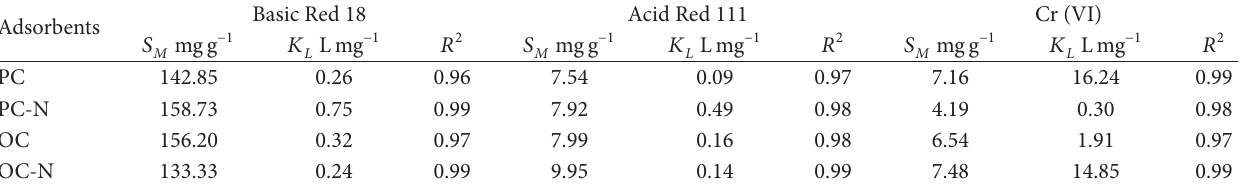
T 3: Parameter of the Langmuir adsorption model of dyes and Cr (VI) (at 25